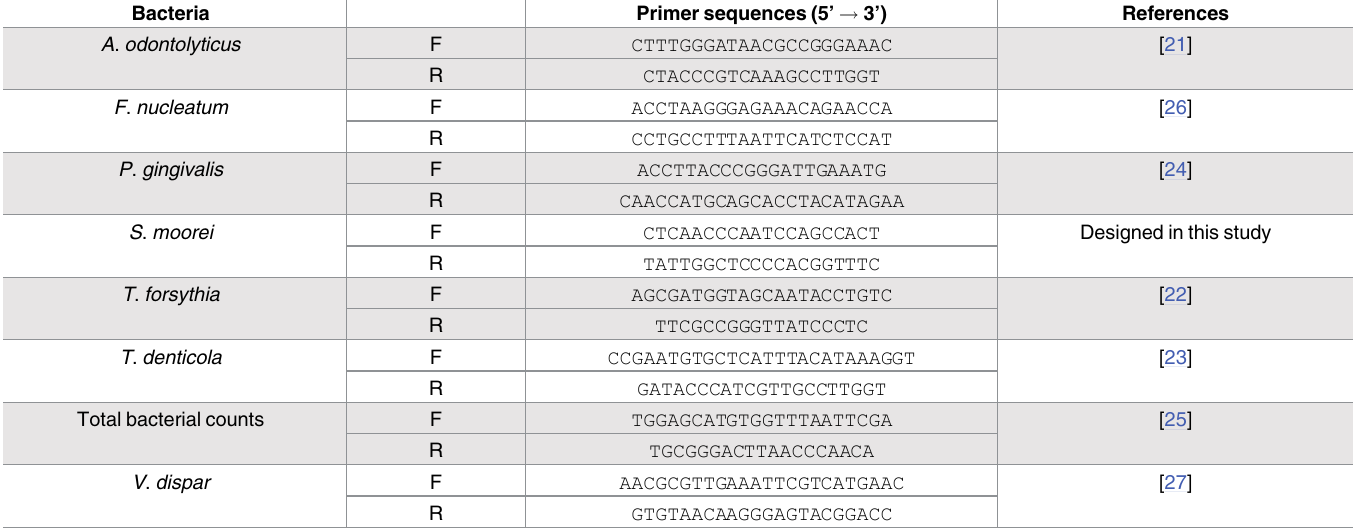
Table 1. Species-specific primers used in the real-time